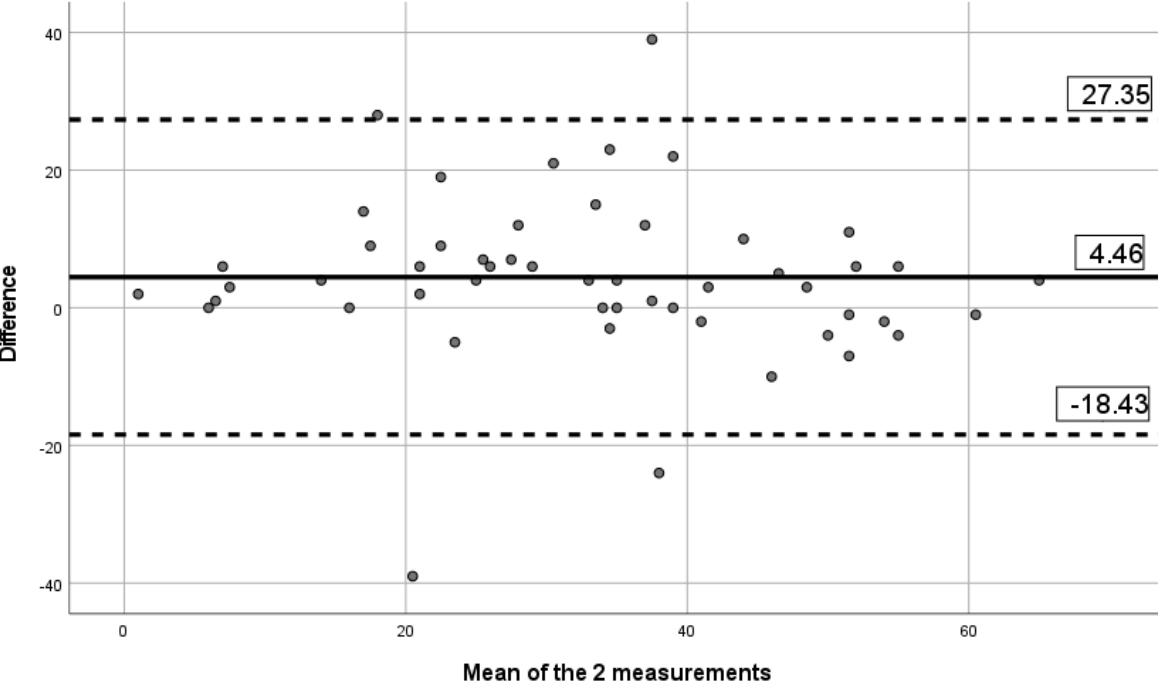
Figure 3. Bland-Altman limits for the Brief Pain Inventory pain interference subscale between the 2 assessments using the